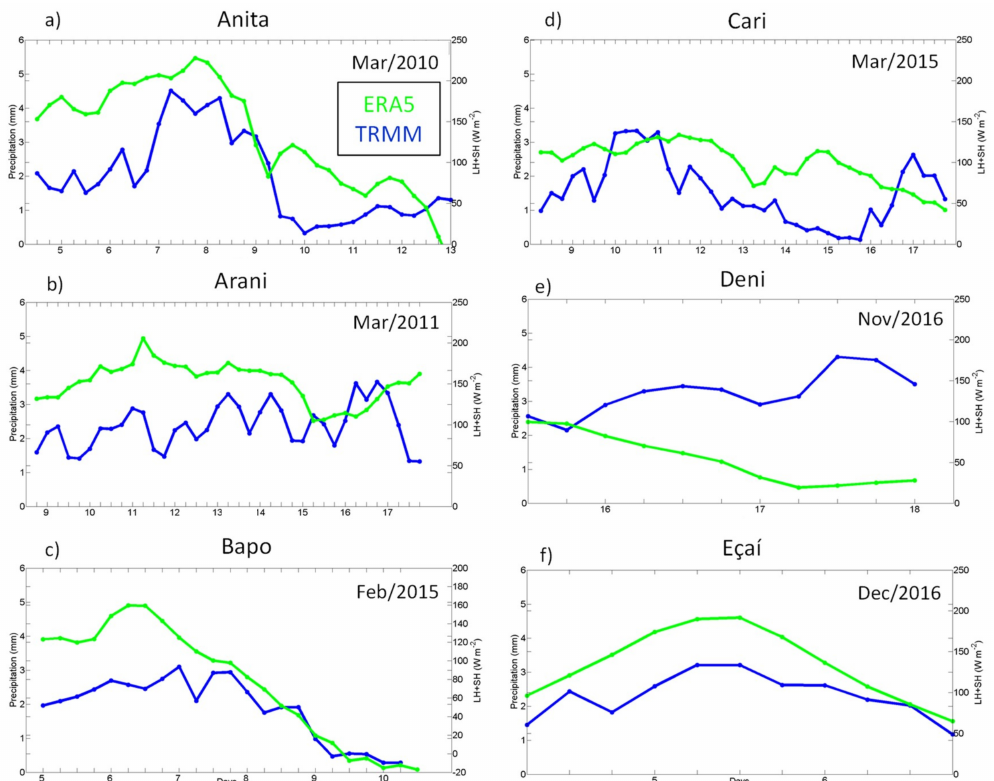
Figure 11. Mean precipitation (mm, blue line) and total (latent plus sensible) heat fluxes (W · m − 2 , green line) every 6h registered in a region of 10 ◦ × 10 ◦ area following the center of the cyclones (Lagrangean analysis): ( a ) Anita, ( b ) Arani, ( c ) Bapo, ( d ) Cari, ( e ) Deni and ( f ) Eça í . For the total heat fluxes only the values over the ocean were